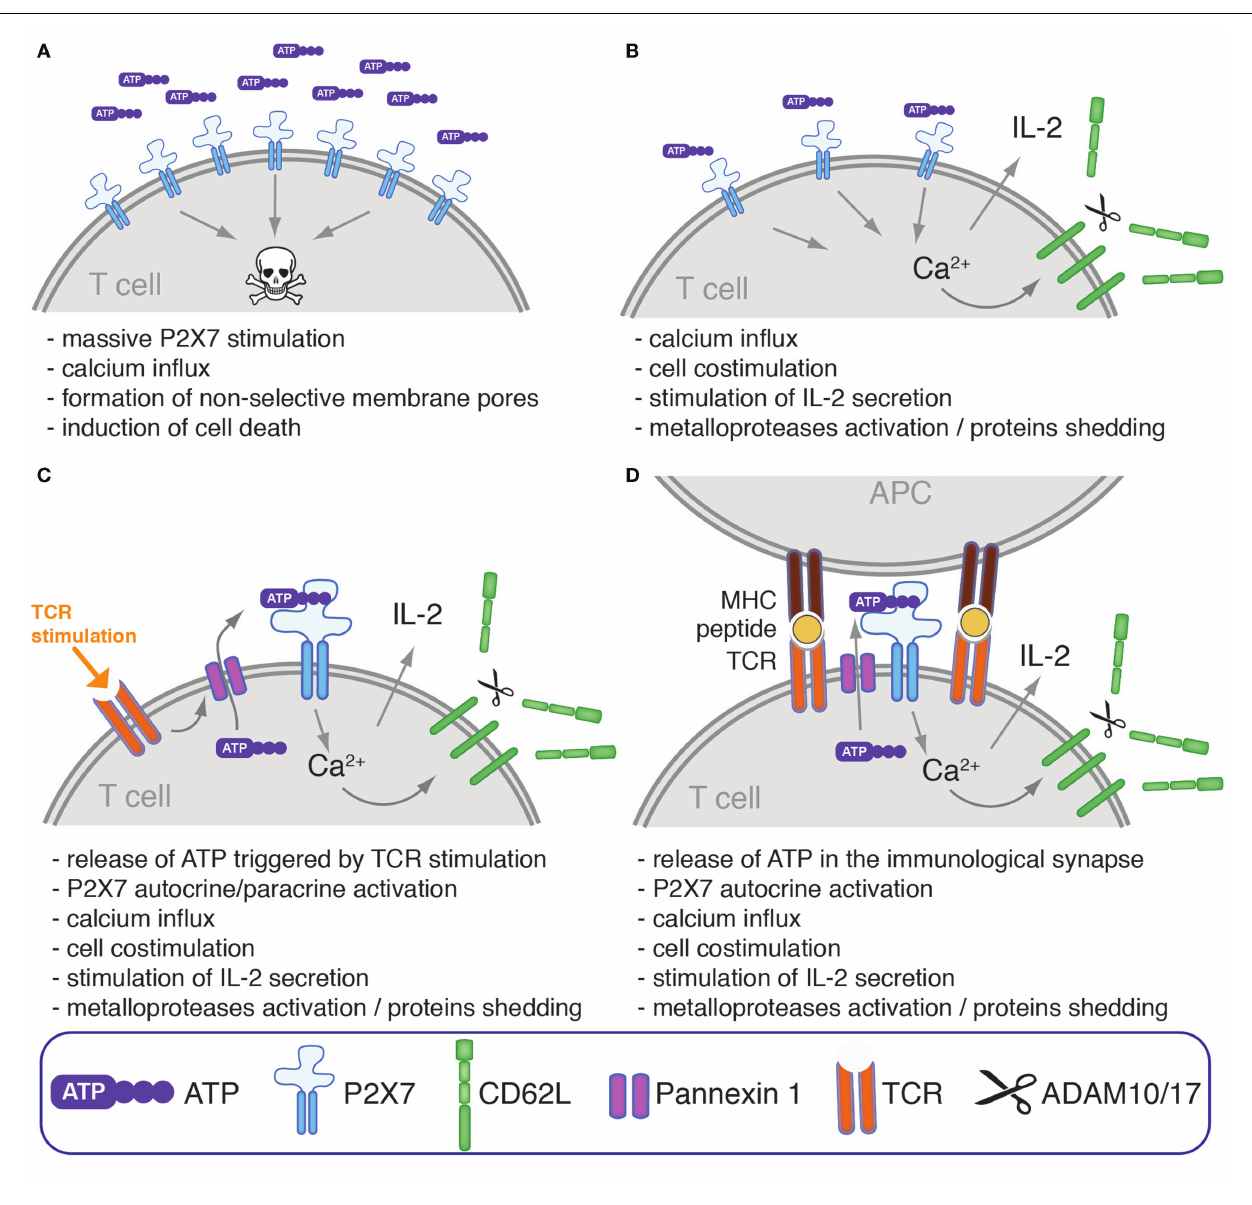
the activation of metalloproteases that catalyze the shedding of CD62L and of other cell surface proteins (79). (C) In some studies, TCR stimulation by mitogenic activators was shown to promote ATP release through pannexin 1 favoring autocrine/paracrine T cell co-stimulation (69, 70, 72). (D) TCR stimulation was also found to stimulate the translocation of pannexin 1 at the immunological synapse together with P2X1 and P2X4 (80). P2X7 is also found within the immunological synapse even if it is not actively translocated within the immunological synapse and remains instead uniformly distributed across the cell surface. This mechanism may thus serve to provide a tonic co-stimulatory signal during physiological activation of a T cell in contact with antigen-presenting cells by promoting the local release of ATP within the immunological synapse, and the local activation of P2X receptors expressed by T cell as well as by antigen-presenting